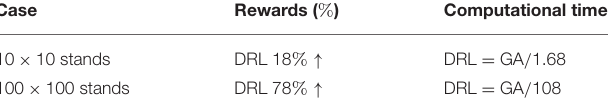
100 stands case. ×